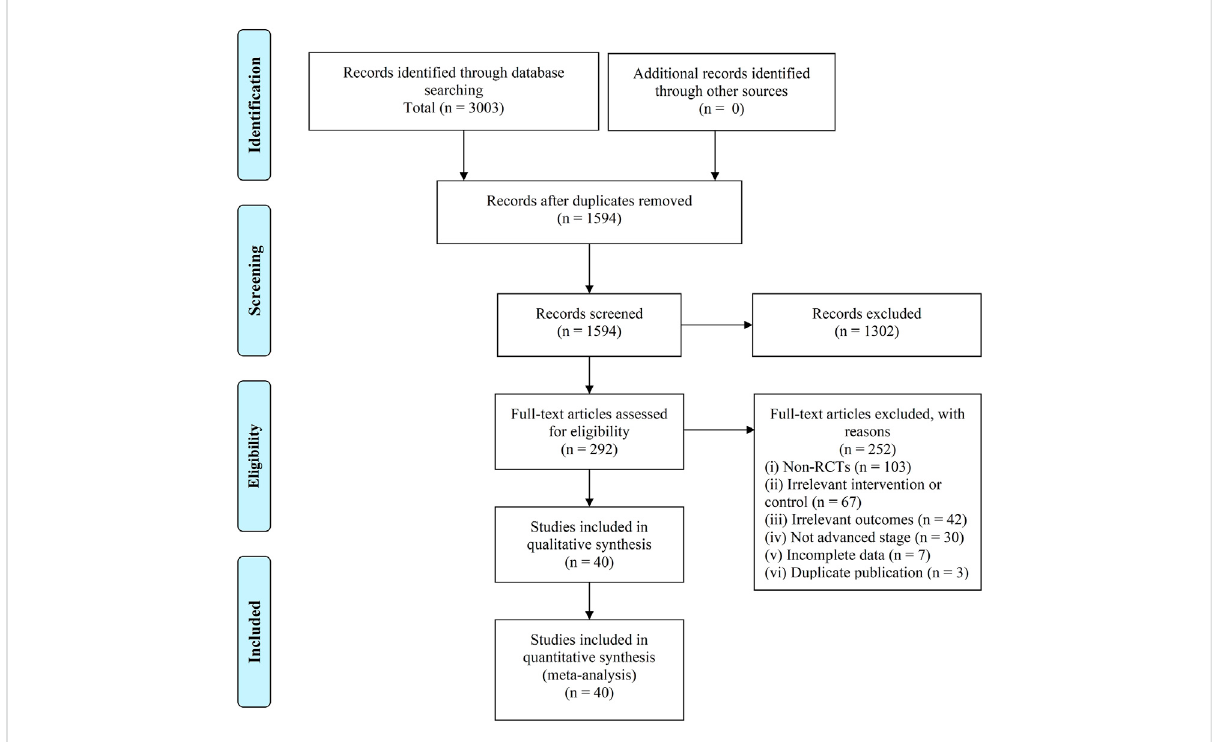
FIGURE 1 Flowchart of records screening and